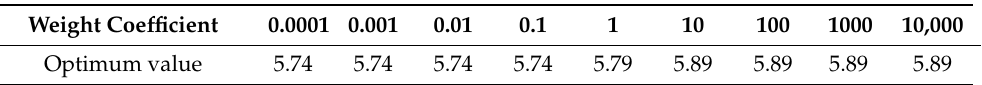
Table 4. The optimum value when the weight coefficient b is from 0.0001 to 10,000.